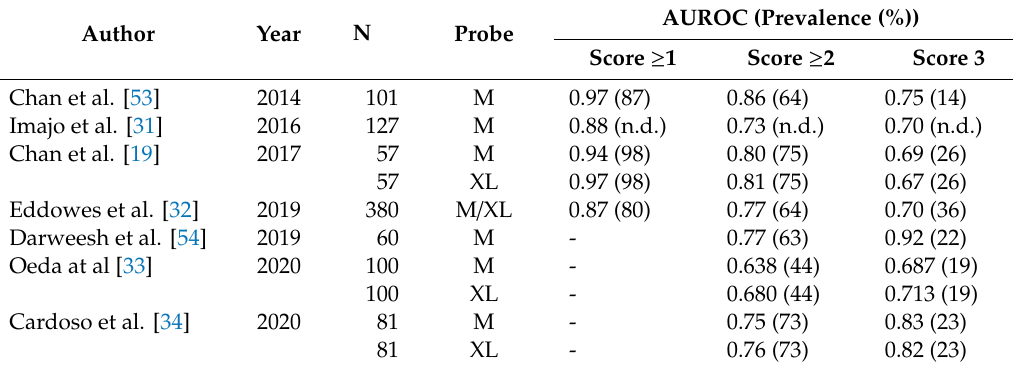
Table 2. Diagnostic accuracy for liver steatosis in patients with